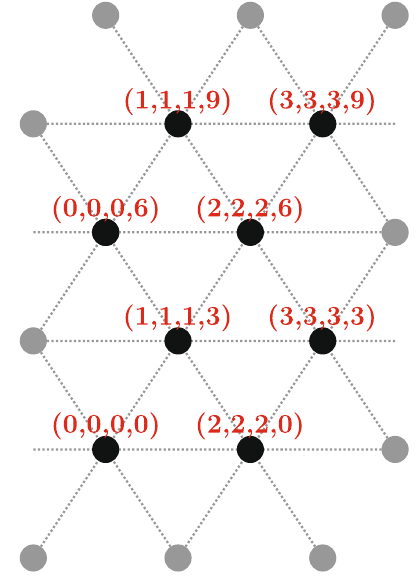
Fig. 3 Illustration of the grid of propagators used in the toy example given in the text. Filled circles indicate sites that lie on the lattice, gray circles are ones accessible through periodicity and the dashed lines indicate lines along our preferred directions ( 1 , 1 , 1 , 3 ) and ( 2 , 2 , 2 , 0